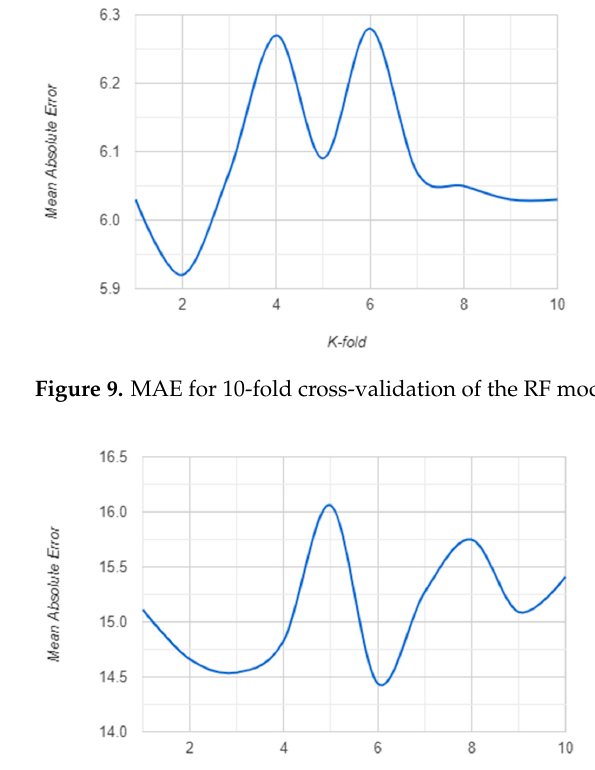
Figure 8. RMSE for 10-fold cross-validation of the XGBoost model.